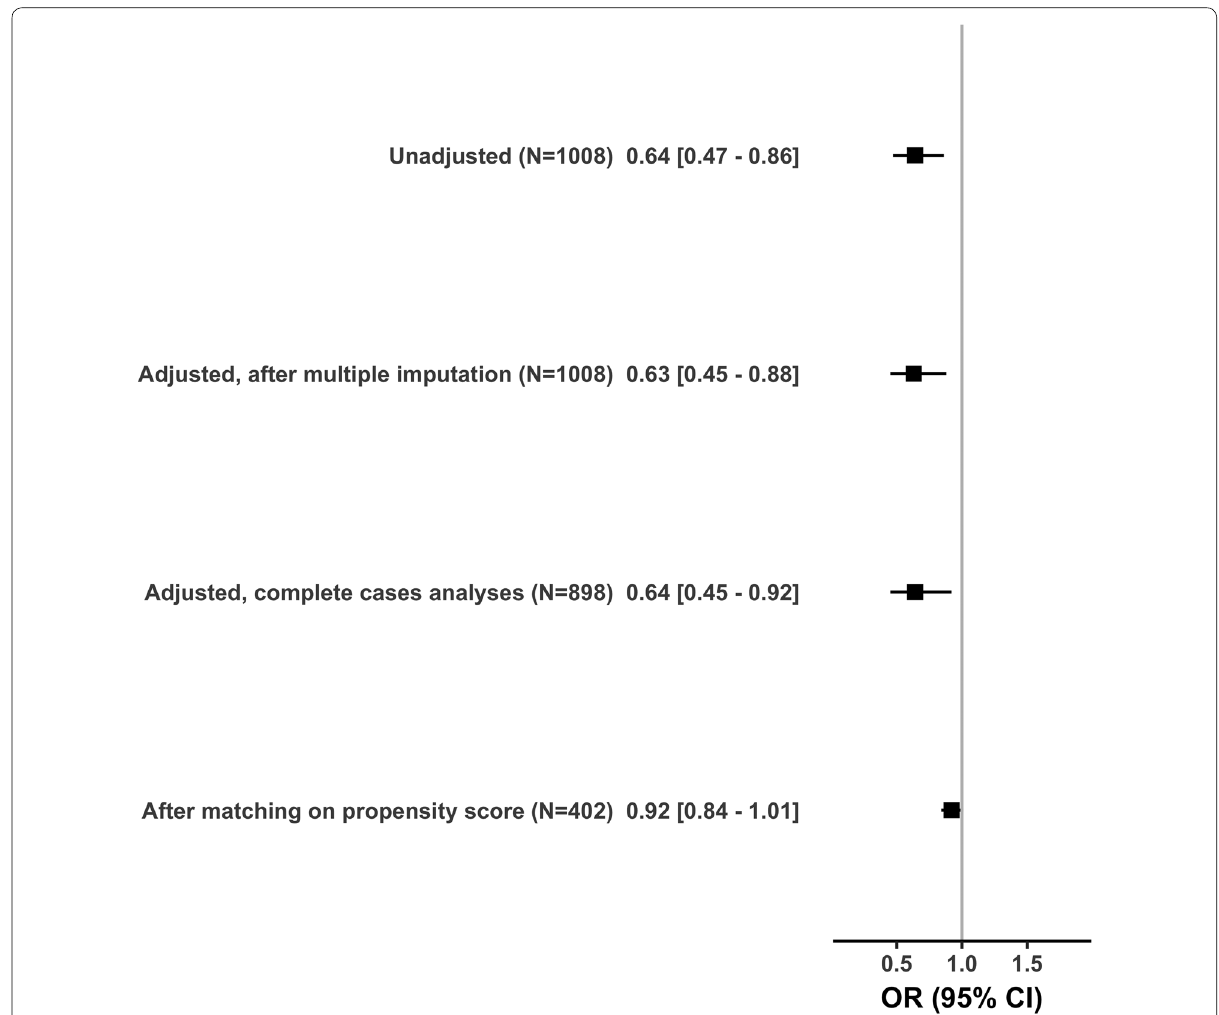
Fig. 2 Effects of direct ICU admission from the ED on hospital